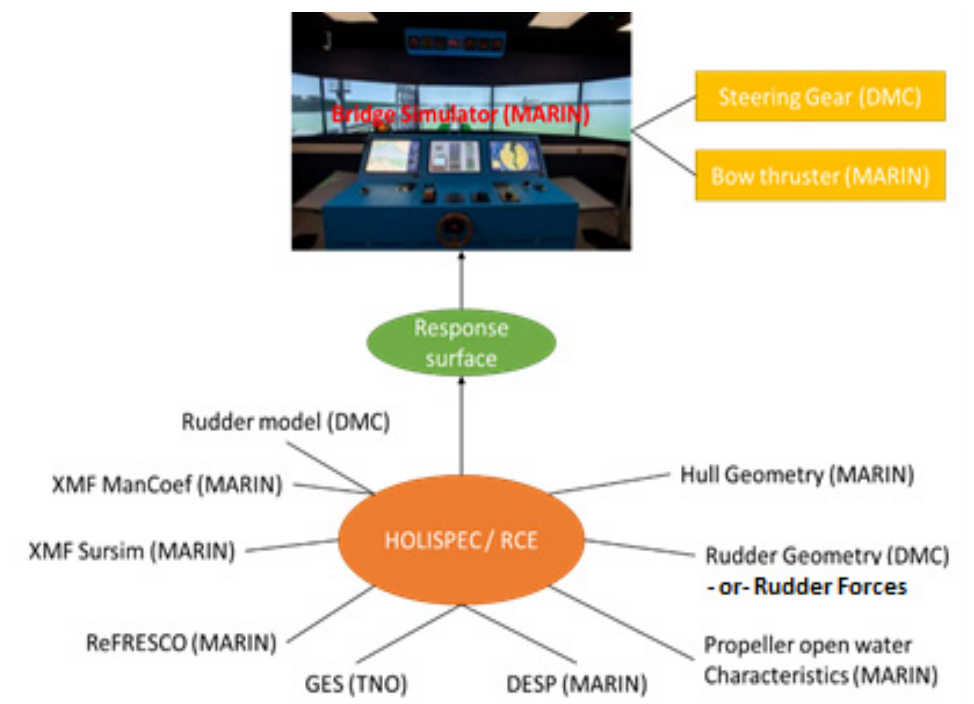
Figure 4. Simulation of Ship Maneuvering and Virtual Prototyping of Rudders (MARIN) [9].